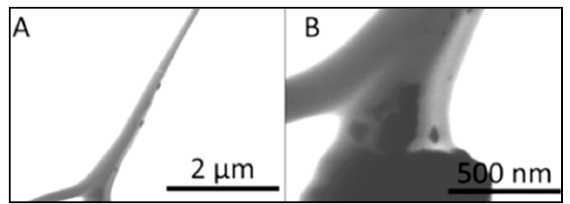
Figure 4. Scanning transmission electron microscopy (STEM) images of magnetic PCL/Aloe vera